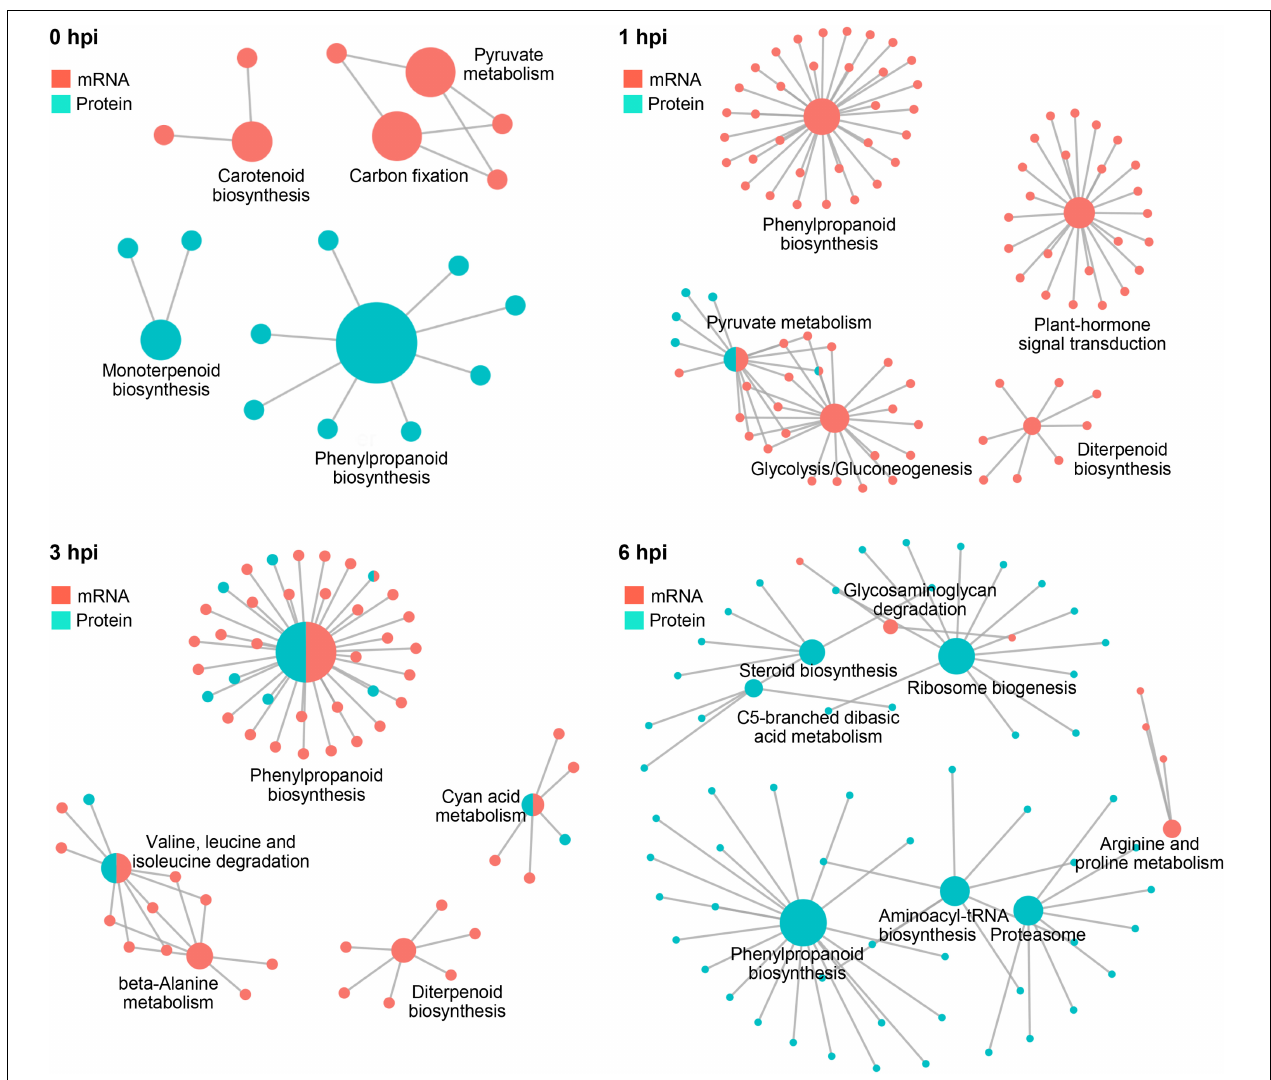
FIGURE 8 | The complex association between enriched KEGG pathways. Plots showing KEGG pathways significantly enriched by DEGs and DEPs detected in RNA-seq and proteomics at 0, 1, 3, and 6 hpi.